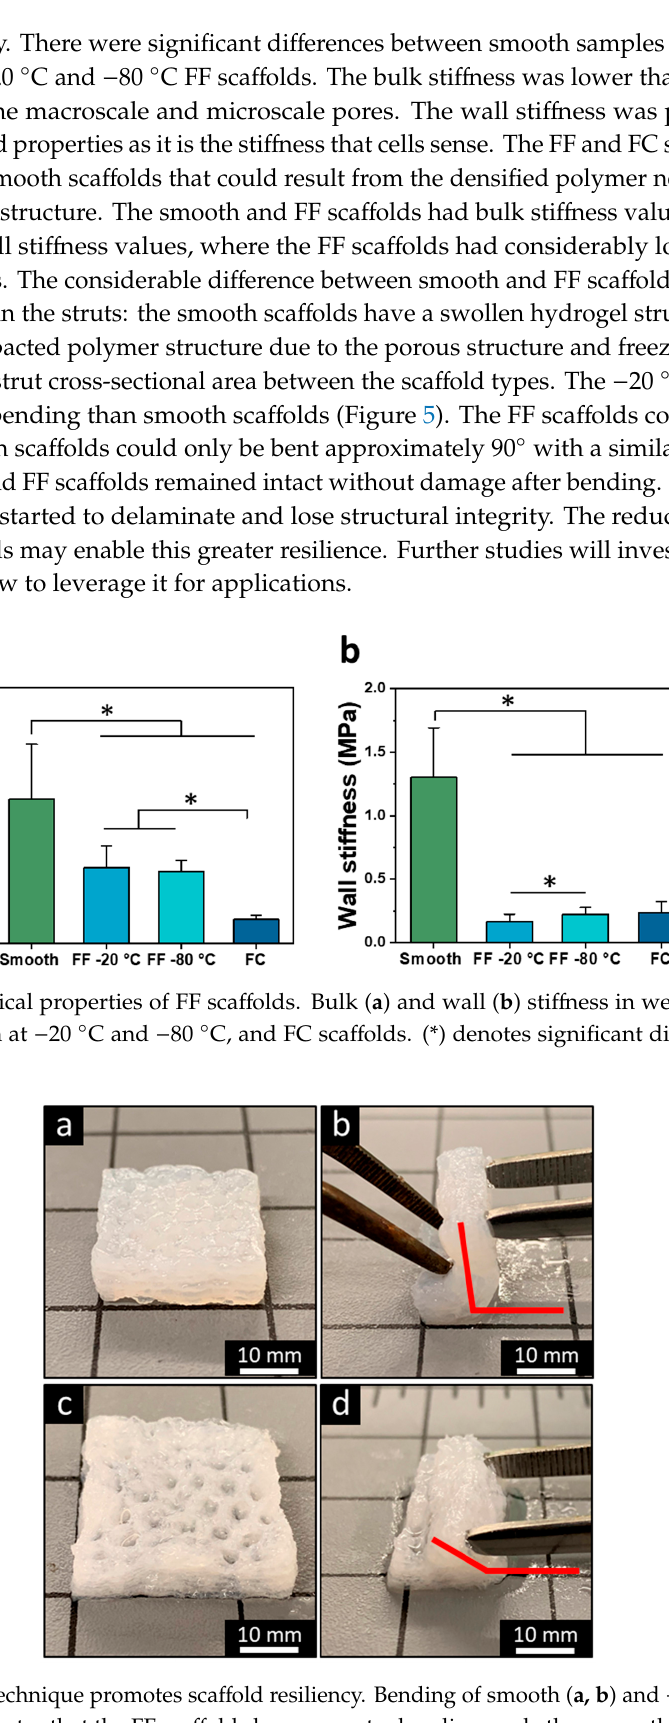
Figure 5. The FF technique promotes scaffold resiliency. Bending of smooth ( a, b ) and − 20 °C FF ( c, d